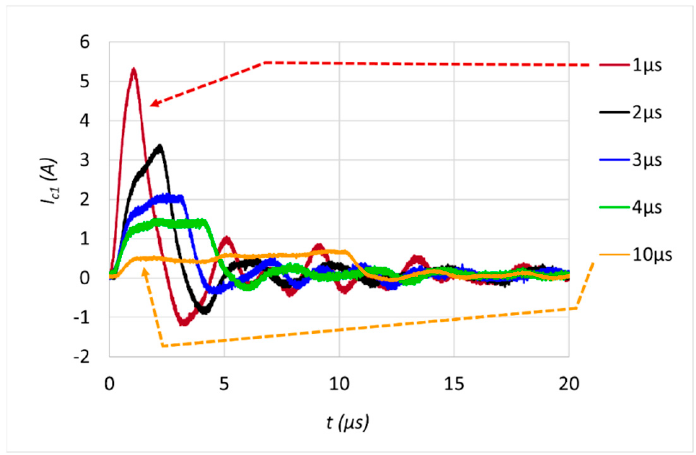
Figure 19. Measured transient current waveforms of one actuator in the stator.